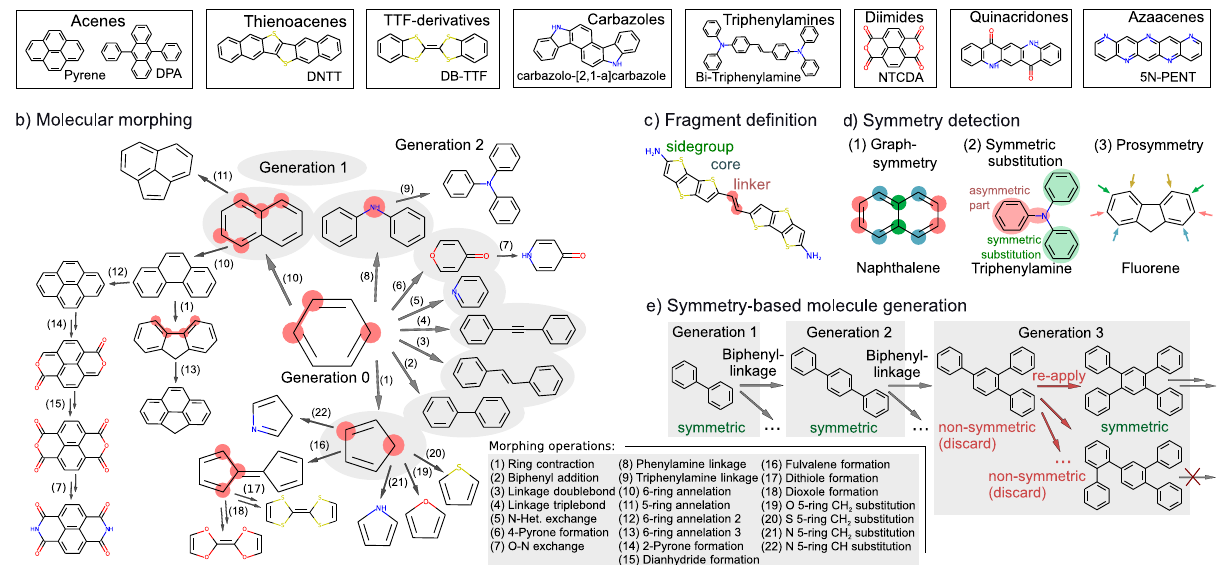
Fig. 1 Molecular construction approach to generate an unlimited OSC chemical space. a Important π -conjugated molecular families and examples of well- performing OSC-molecules therein. Molecular morphing operations are designed such that the generated OSC space includes these families. b Schematic overview of the molecular generation process. Starting from benzene, diverse molecules are created by iterative application of up to 22 morphing operations. The fi rst generation resulting from the 8 morphing operations applicable to benzene is fully shown. Molecules in further generations are only shown as examples, but every operation type is depicted at least once, see also Supplementary Fig. 2 for an extended depiction. c Fragment-de fi nitions used throughout the text exempli fi ed for the molecule BDTTE. Connected aromatic ring structures are cores. Linkers and sidegroups both branch from a core structure with a single bond, but are either connecting to at least two core structures or only bonded to one core fragment. d Concepts for symmetry detection used throughout the molecular generation process. e Modi fi ed molecular morphing step, adapted to the symmetry constraints imposed on candidate